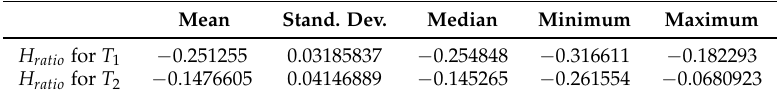
Table 4. Statistics of H ratio exp for the T 1 w and the T 2 w images for the 45 HCP Retest volunteers. The H ratio exp are significantly negative for all images and hence all the restorations are successful. Mean Stand.